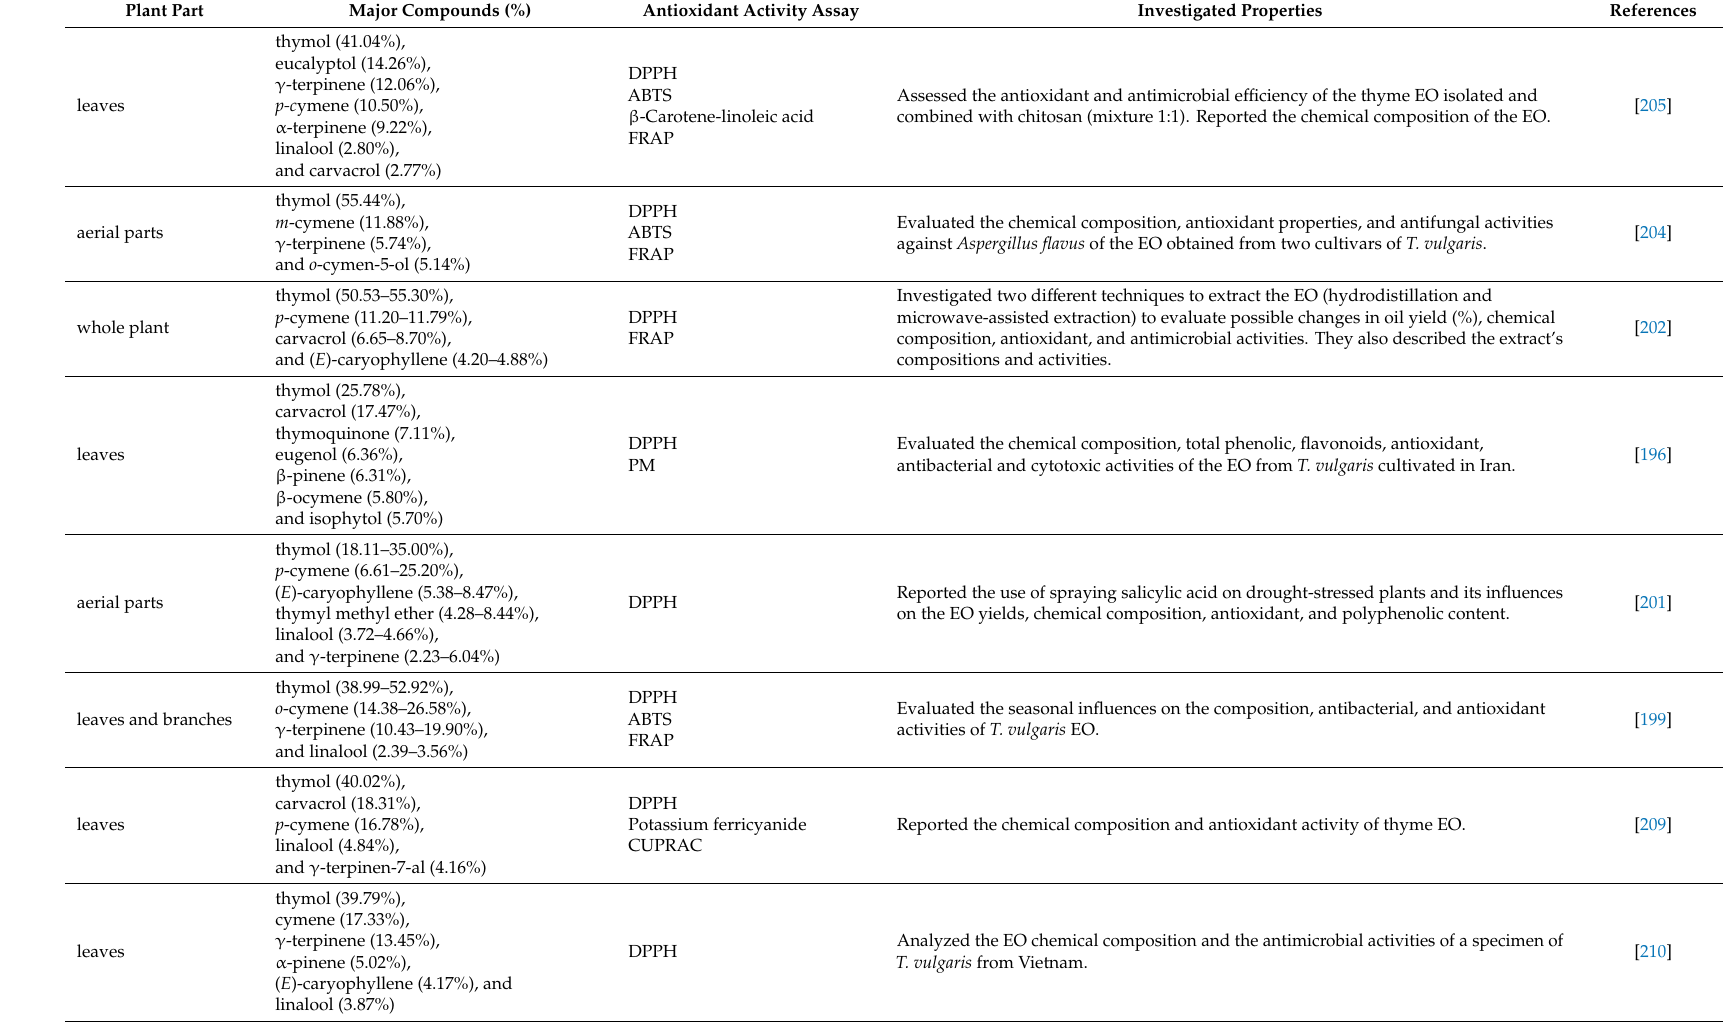
Table 7. Major natural compounds, methodologies applied to determine the antioxidant activity, and the investigated applications of Thymus vulgaris (Lamiaceae) EOs. Plant